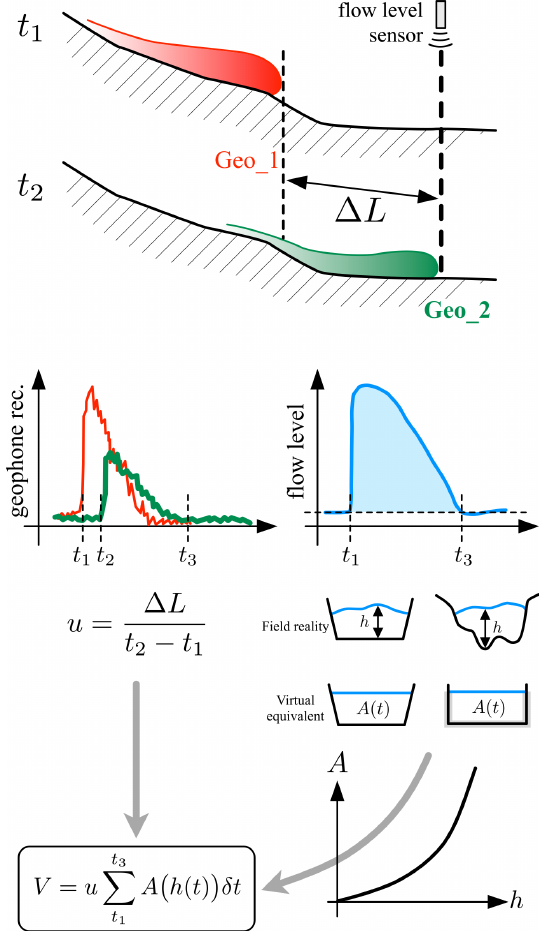
Figure 1. Synthetic overview of the method: a pair of sensors are used to estimate the time travel (cid:49)t between known locations, and an assumption about the cross-section shape along with the flow depth sensor is used to compute the wetted area A(t) and the associated surge parameters: discharge Q(t) , volume V and Froude number Fr . The Geo_X labels represent